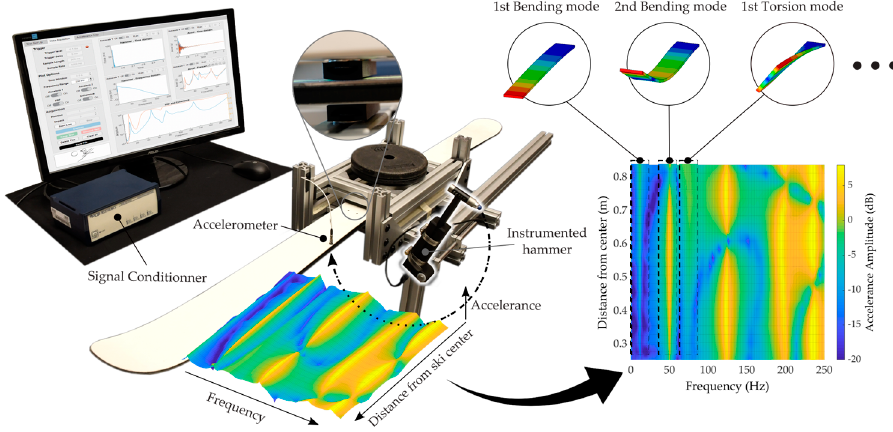
Figure 1. The developed test bench to measure accelerance maps on skis. Modes shapes are from